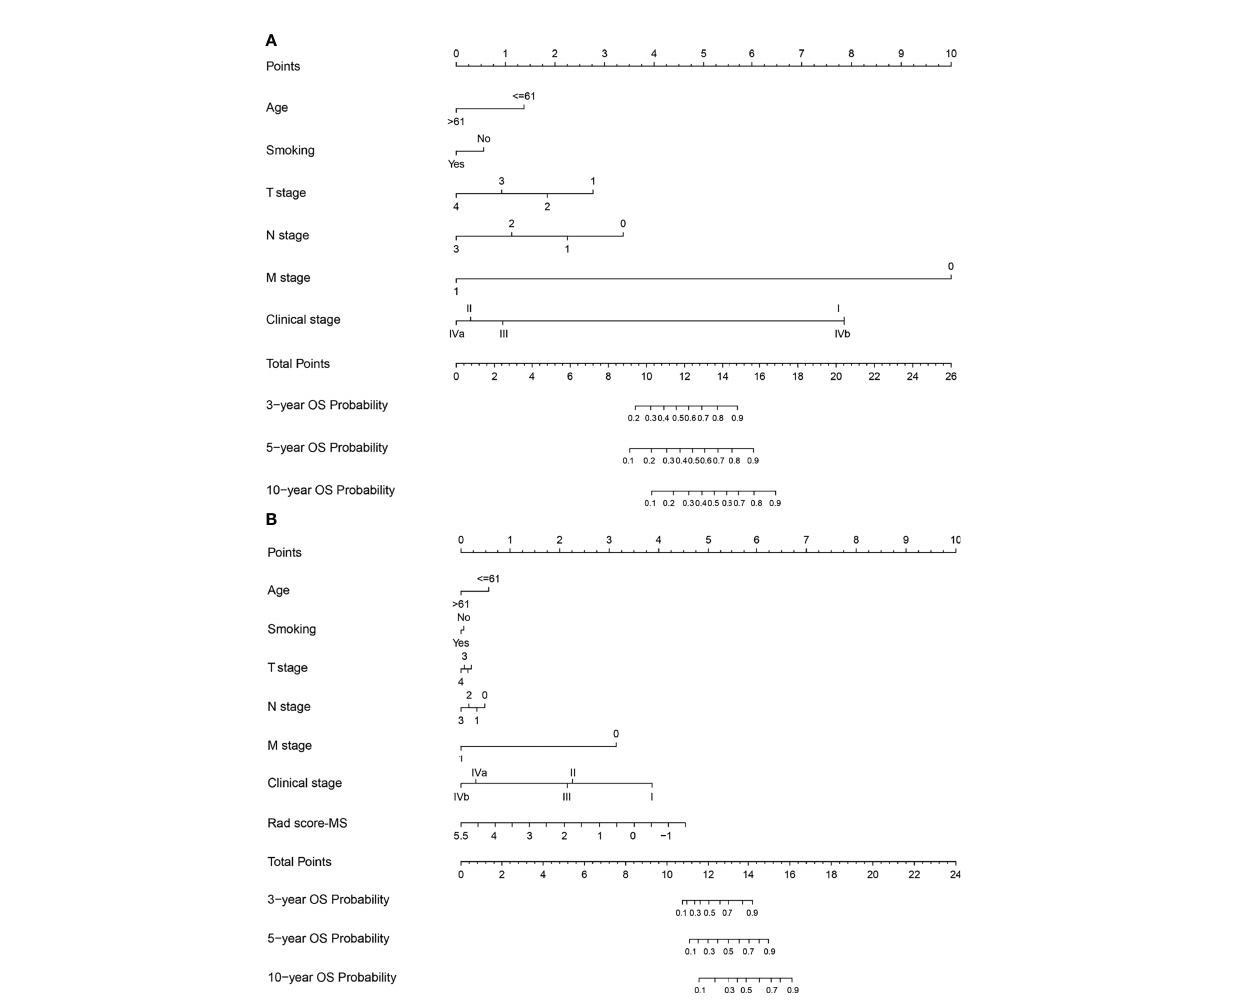
FIGURE 6 | Nomograms developed for the training cohort. (A) Clinical nomogram and (B) radiomics nomogram-MS.